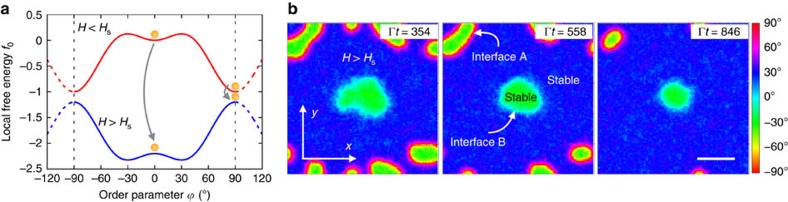
Two physically different interfaces connect the two equilibrium phases.(a) Model energy landscape of the LIPT, equation 2. The dashed part illustrates the periodicity of the potential. (b) Simulation snapshots of the phase-ordering process that results from a quench from H<Hs to H>Hs (see Supplementary Movie 2). Colour indicates the order parameter field (r, t) of the model. From an initial coexistence of a stable =90° (red) and a metastable =0° (light blue) domains, the system undergoes a double spinodal decomposition. This leads to the formation of two physically different interfaces (A and B) connecting the two equilibrium phases =±30° (dark blue and green, respectively). Γ−1 and  define the time and length units in the simulations, respectively. Scale bar, 50.